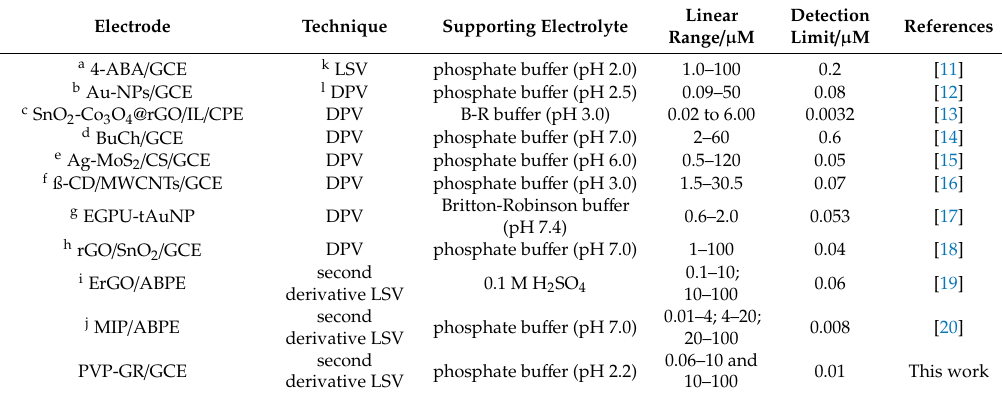
Table 1. Comparison of the e ffi ciency of polyvinylpyrrolidonefunctionalized graphene (PVP-GR) / glassy carbon electrode (GCE) with other modified electrodes in the electrochemical determination of